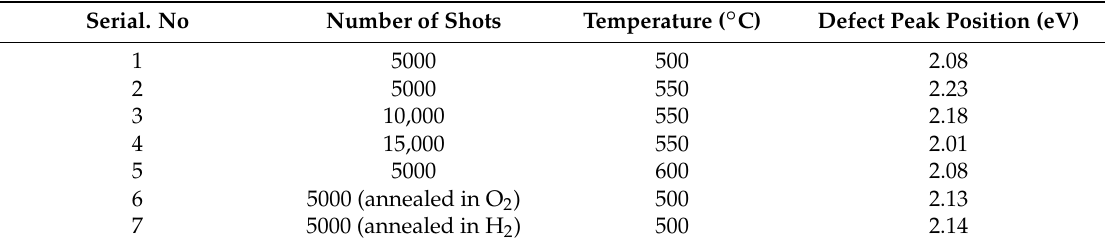
Figure 6. PL spectra of ZnO nanorods grown at 500 °C and annealed in ( a ) O 2 atmosphere ( b ) H 2 atmosphere. Table 4. Defect peak positions of VAZO nanorods from PL spectra.